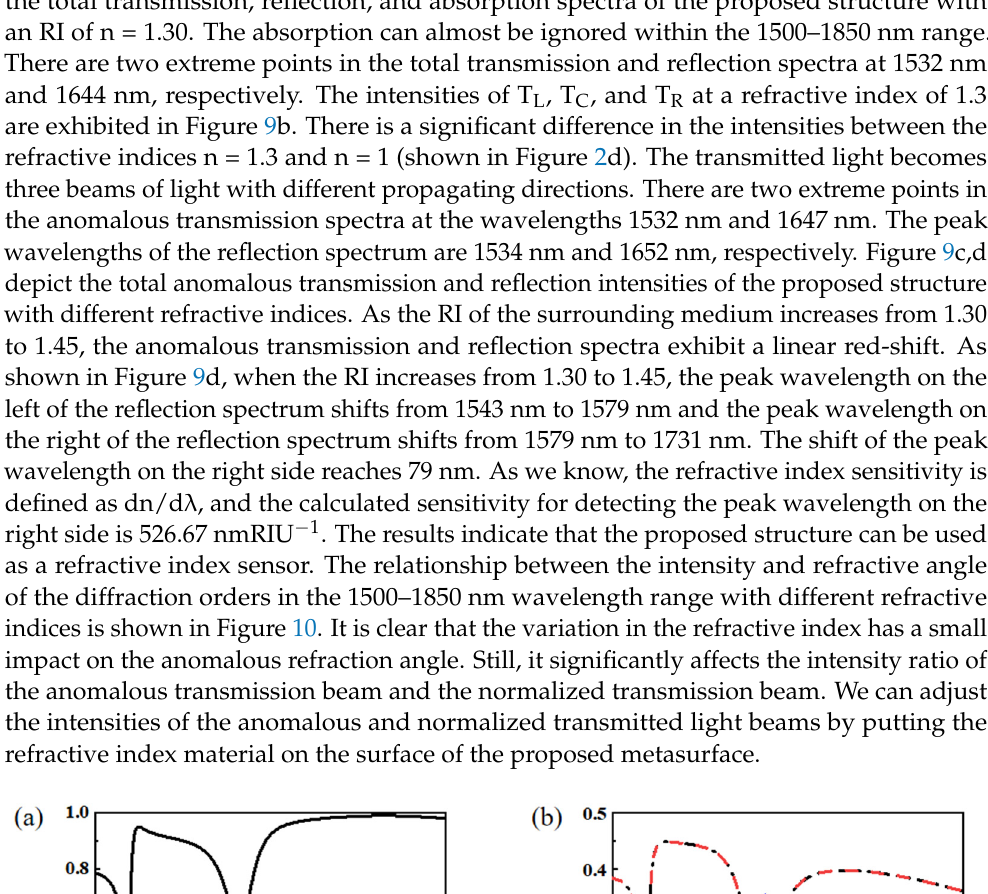
Figure 10. The relationship between the transmission intensity and refractive angle of the diffraction orders in the wavelength range of 1500-1850 nm with different refractive indices. ( a ) n = 1.30, ( b ) n = 1.35, ( c ) n = 1.40, and ( d ) n = 1.45.